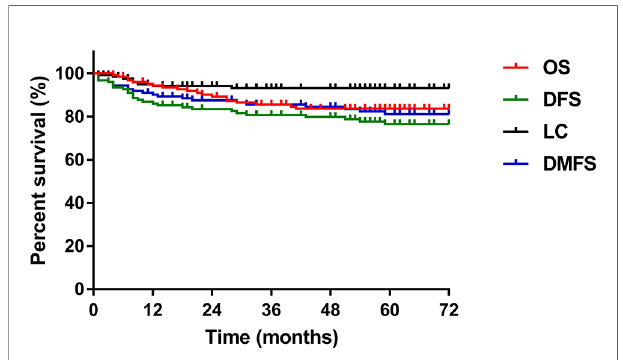
FIGURE 1 | The 5-year OS, DFS, LC, and DMFS curves of the study patients. OS, overall survival; DFS, disease-free survival; LC, local control; DMFS, distant metastasis-free survival.